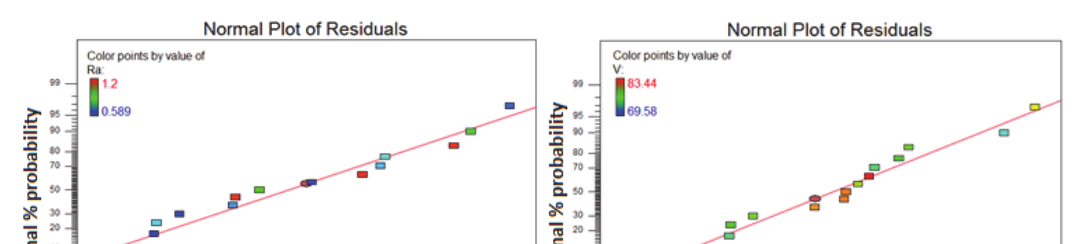
Fig. 5. Predicted vs. actual response plot of tool vibration